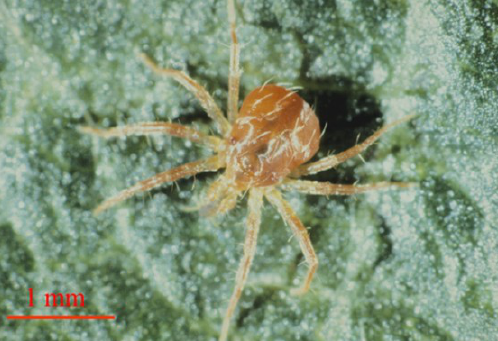
Figure 1. Adult female of the beneficial whirligig mite, Anystis baccarum (Photo: Andrew G. S. Cuthbertson ©